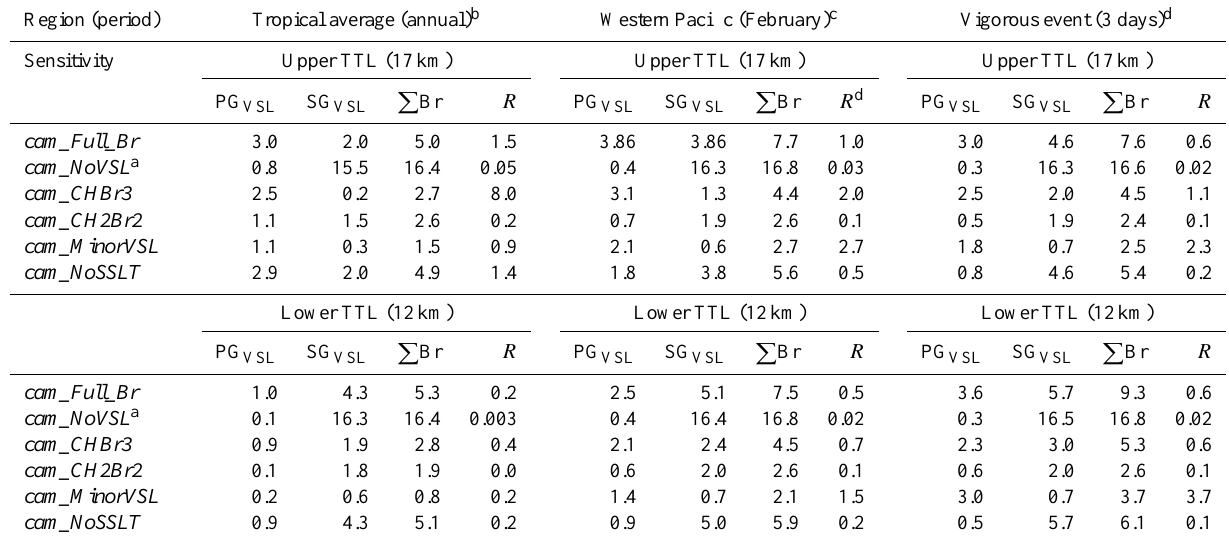
Table 4. Partitioning of SG VSL and PG VSL species within the TTL for different CAM-Chem simulations. Region